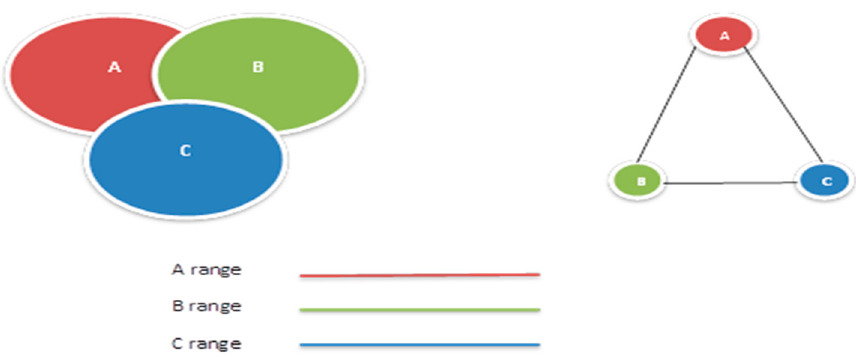
Figure 2. Wireless network and the corresponding graph model.